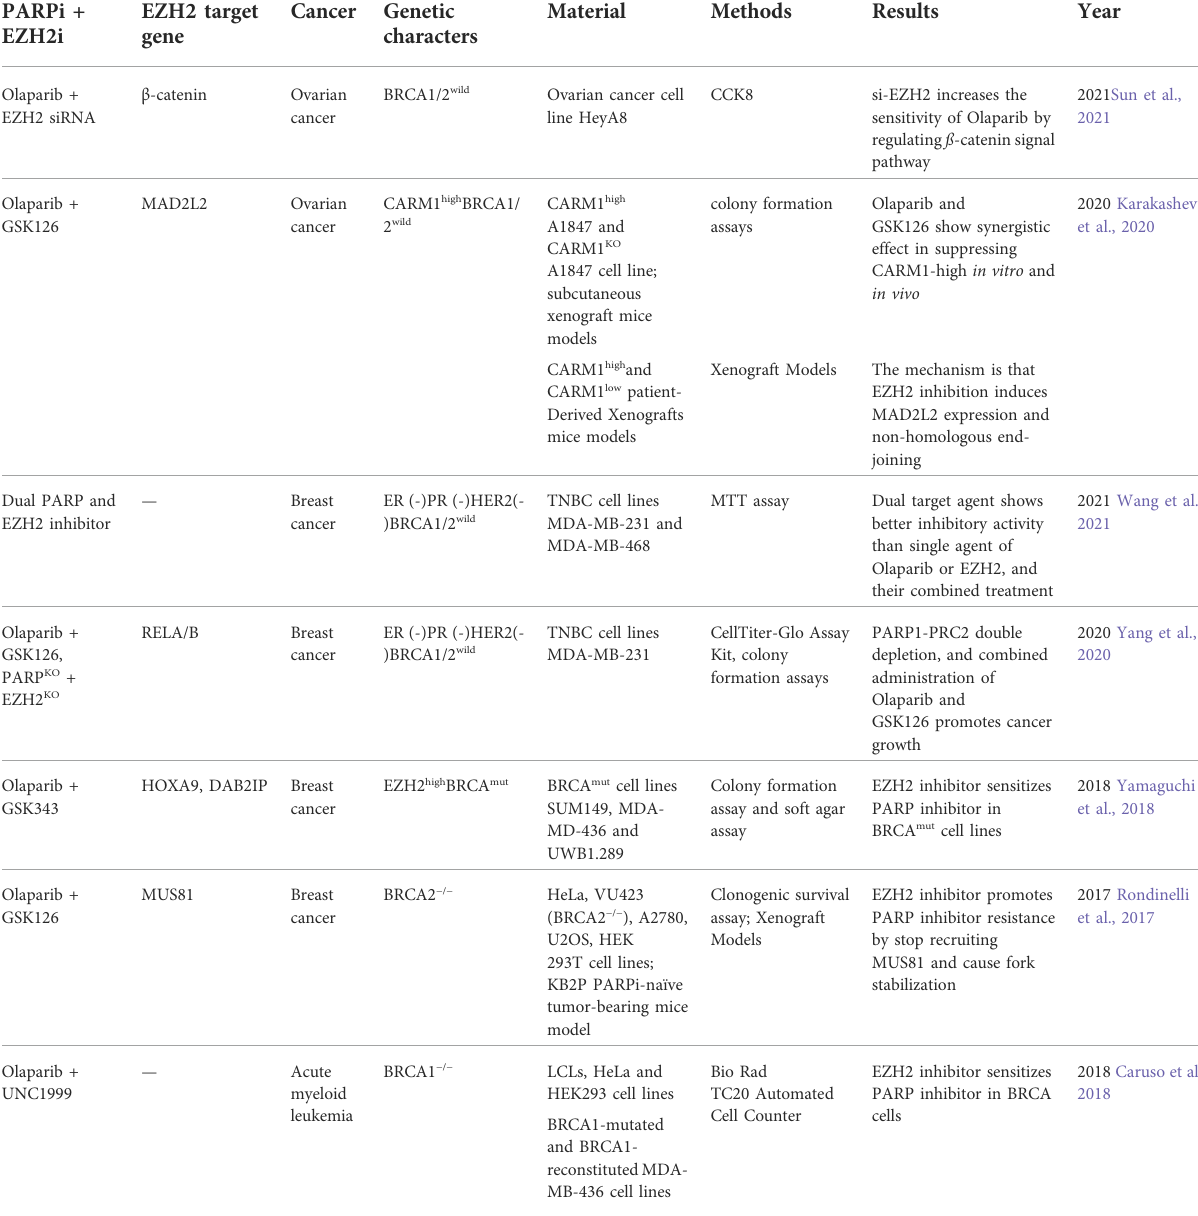
TABLE 1 EZH2 inhibitors in combination with PARP inhibitors in pre-clinical researches. PARPi +